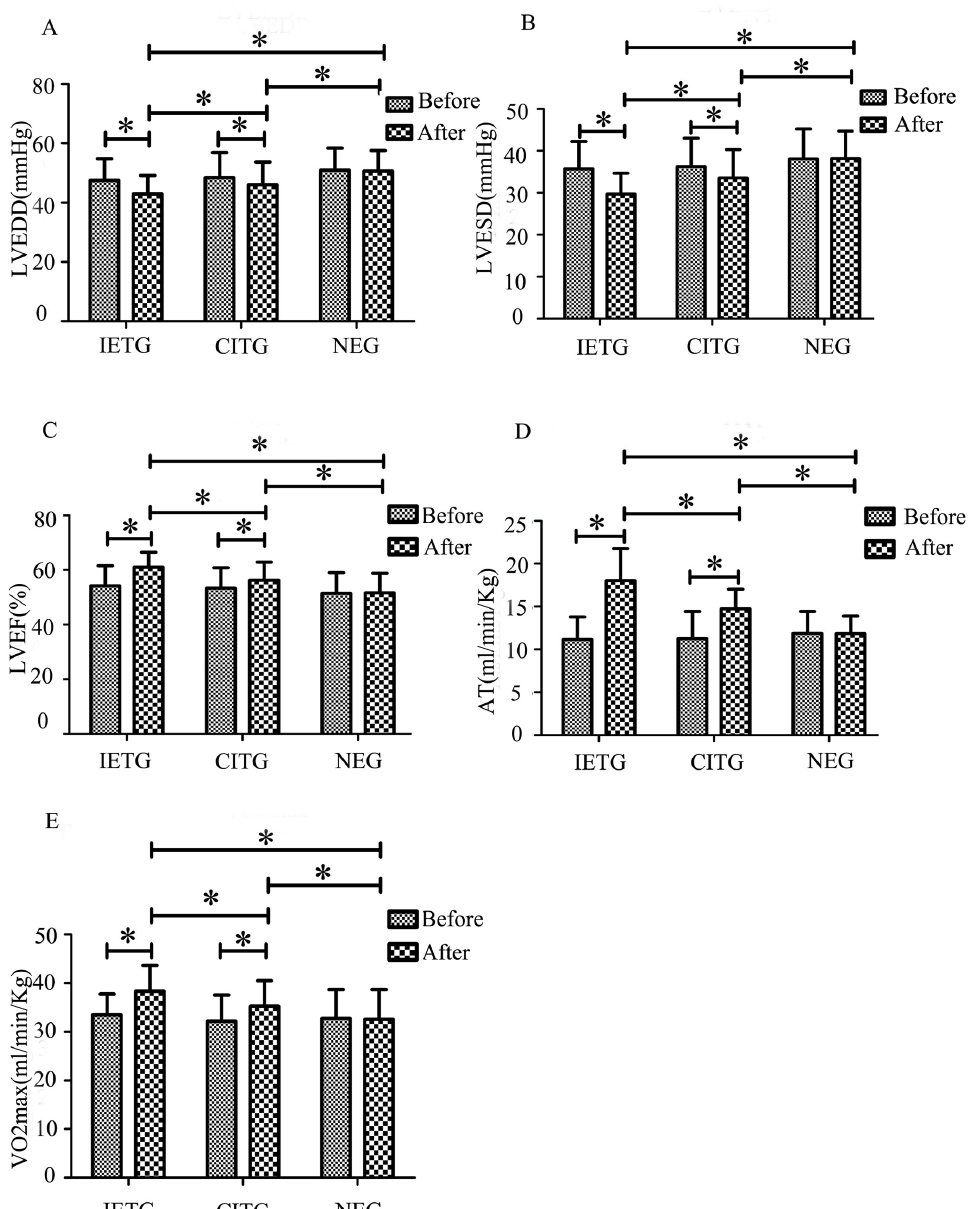
Figure 4: Comparison of the cardiac structure (A,B); Comparison of the cardiac function